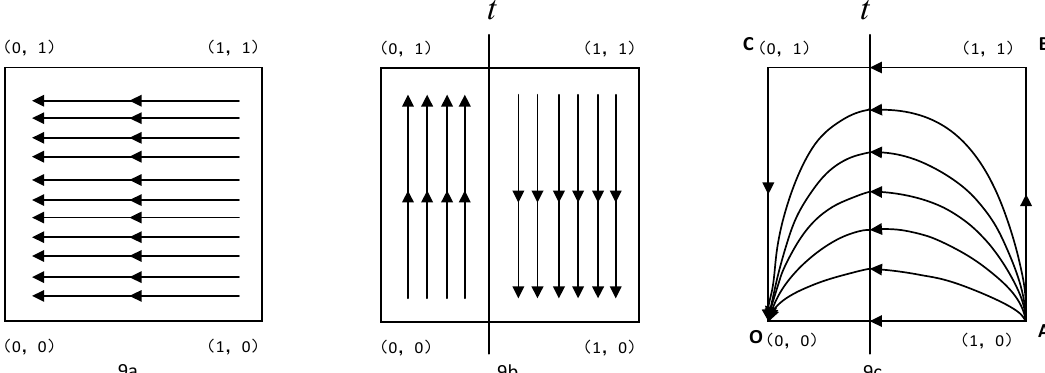
Figure 9. Analysis of the evolution process in Case 3. ( a ) Power grid companies; ( b ) users; and ( c ) power grid companies and users.